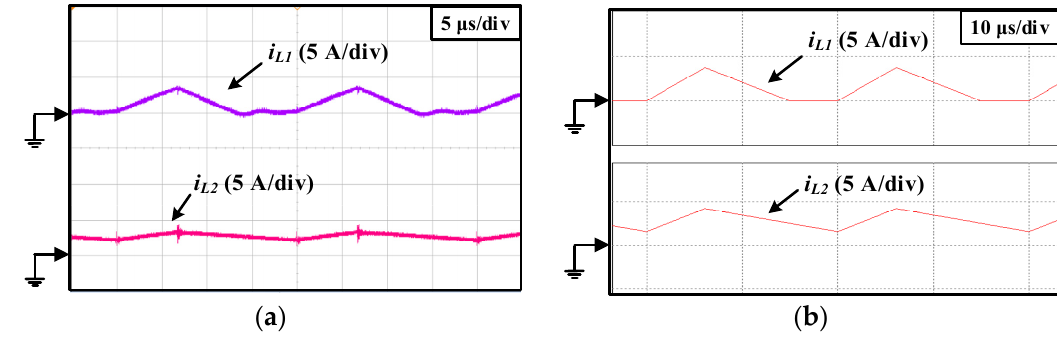
Figure 16. The waveforms of i L 1 and i L 2 : ( a ) practical measurements, and ( b ) simulated results.